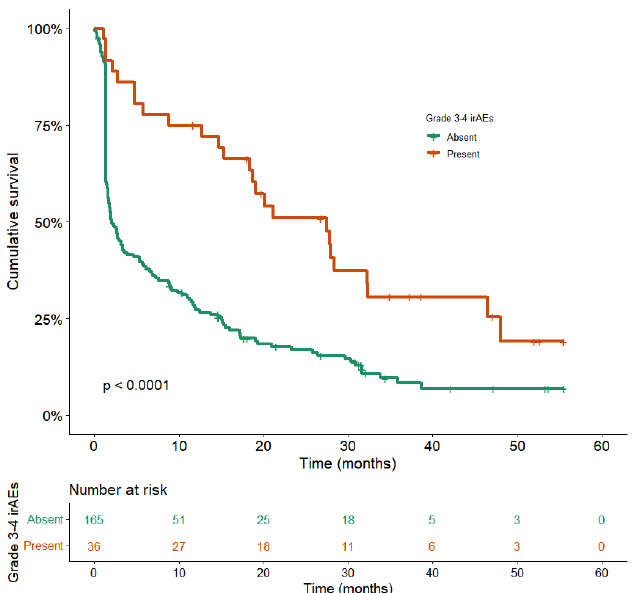
Figure 5. TTNT according to the occurrence of Grade 3 – 4 irAE. Time to next treatment (TTNT) Kaplan – Meier curves, according to the occurrence of Grade 3 – 4 irAEs. Median TNT was 27.5 months (95%CI: 16.2 – 38.8) in the case of Grade 3 – 4 irAEs, but only 2.1 months (95%CI: 1.1 – 3.1) in absence of Grade 3 – 4 irAEs ( p < 0.0001, Log-Rank